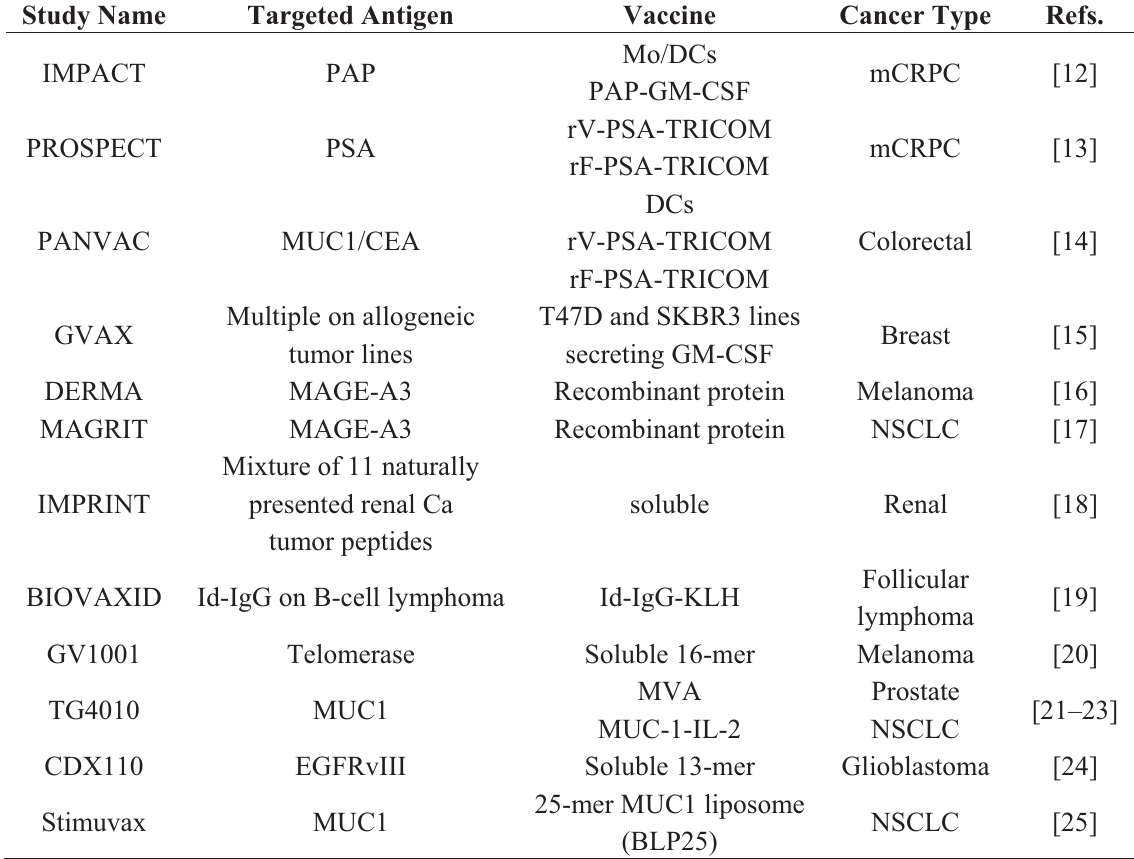
Table 1. Phase II and III clinical trials, utilizing various therapeutic vaccine